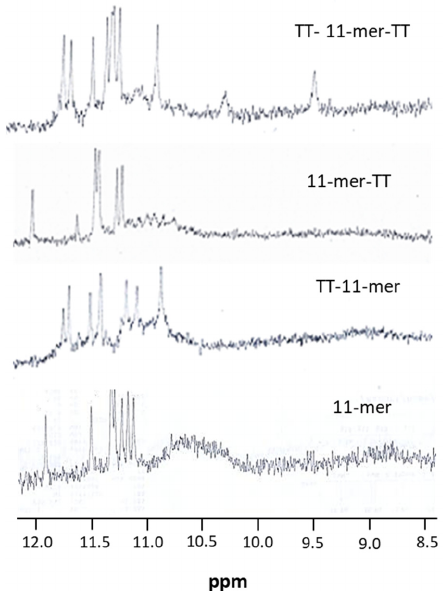
Figure 5. Imino and amino regions of the 1 H NMR (500 MHz) spectra of the 11-mer and its deriva- tives containing flanking TT at the 3 ′ end, 5 ′ end or both. See the main text and the experimental (cid:48) end, 5 (cid:48) end or both. See the main text and the experimental section section for details. containing flanking TT at the 3 for